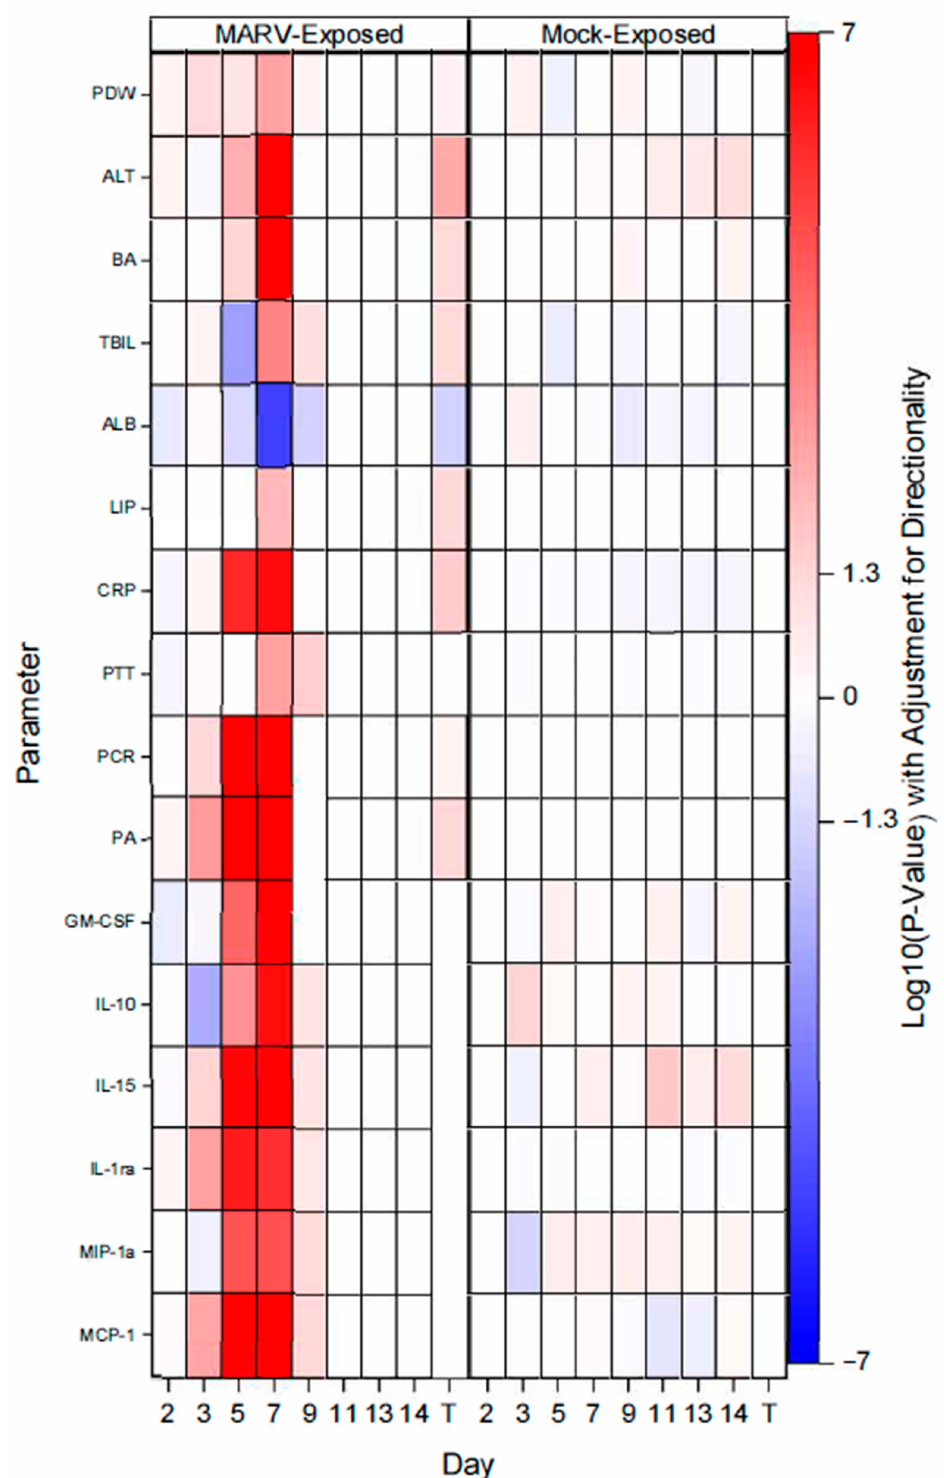
Figure 8. Onset of Abnormality Heat Map. PDW—platelet Distribution Width; ALT—alanine trans ‐